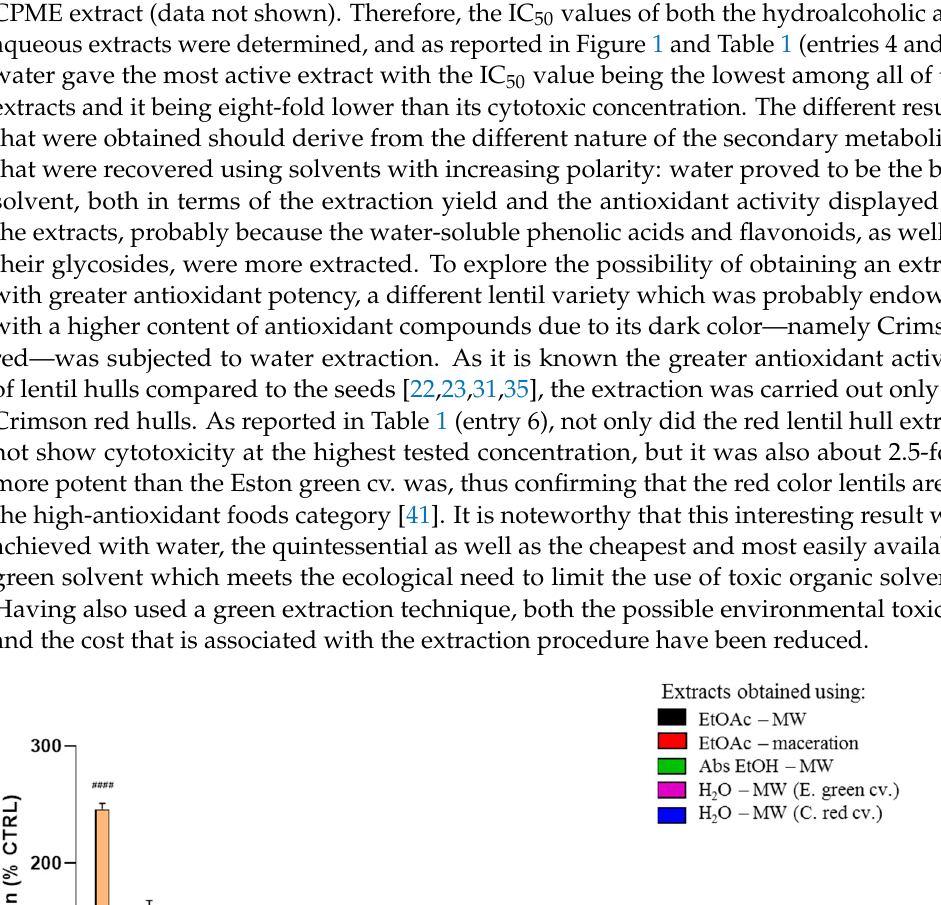
Table 1. Antioxidant activity of seeds and hulls lentil extracts, obtained with different solvents, on SH-SY5Y cells.